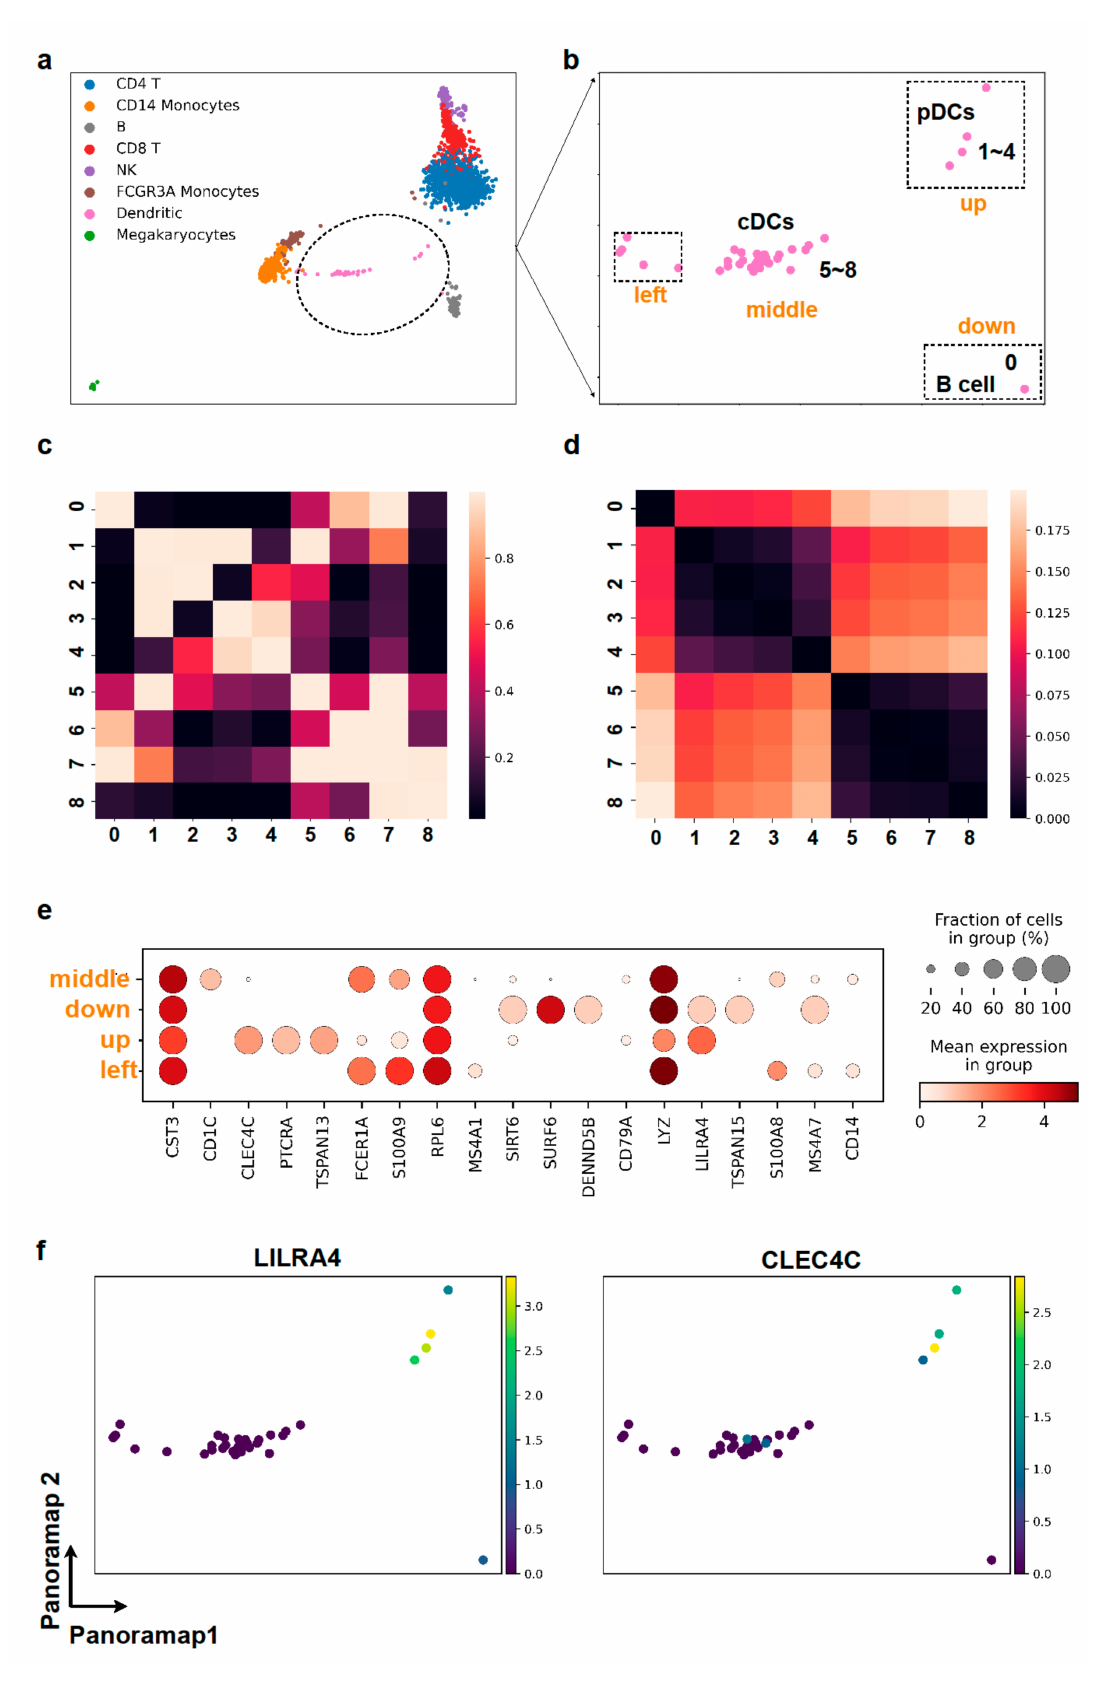
Figure 5. Panoramap reveals delicate cell populations. ( a , b ) In Panoramap embedding for PBMC3k dataset, the dendritic cell population is separated into one major group in the middle (e.g., points 5–8) and several points (points 1–4) up between B cells and T cells, one point down which is very close